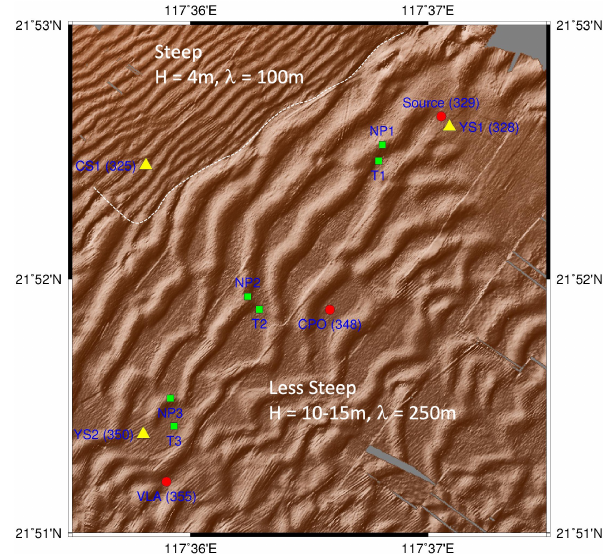
Figure 2. The sea floor in the study region as observed by a multi- beam echo sounder (MBES) survey during June 2014. The region is delineated by the black box in Fig. 1. The dotted white line indicates a sharp change in bottom slope, steeper towards the